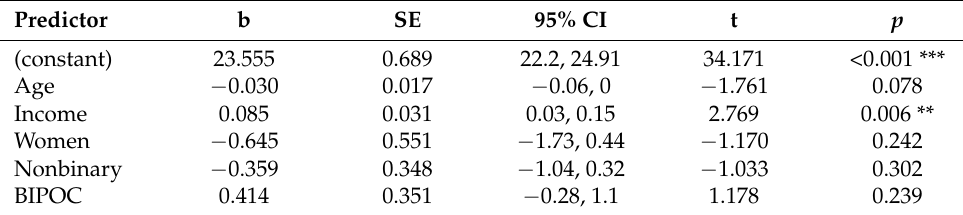
Table 4. Predicting QOL by demographics.